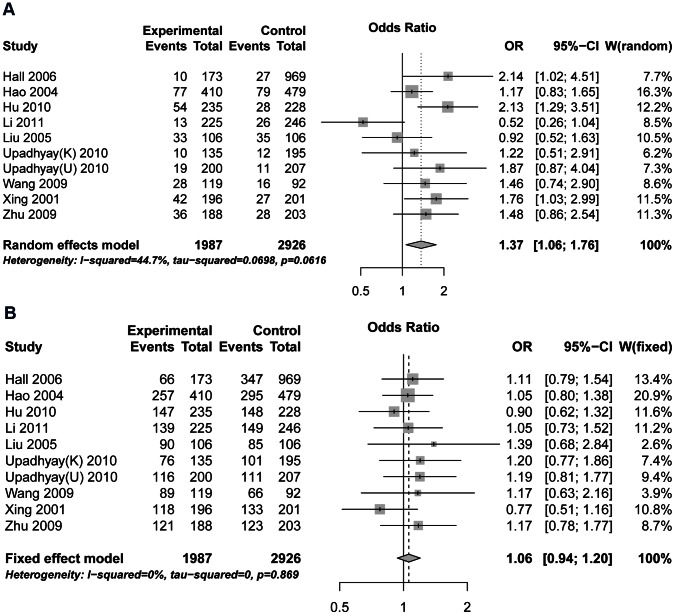
Forest plots of odds ratios (ORs) with 95% confidence limits (CIs).The center of each square represents the OR. The area of the squares reflects the weight, and the horizontal line indicates the 95% CI. (A). recessive model; (B). dominant model.